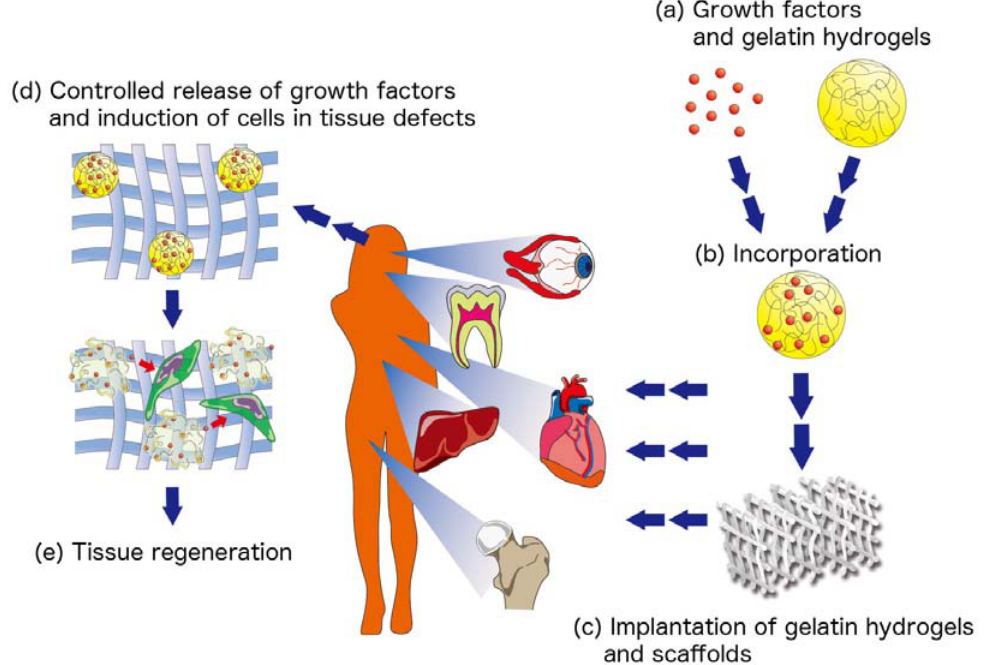
Figure 5. Scheme for controlled release of growth factors from gelatin